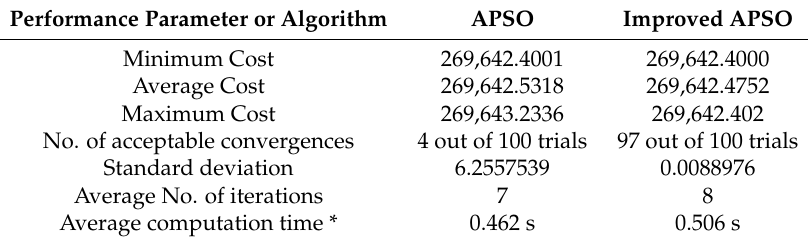
Table 2. Comparison of some performance parameters between APSO and improved APSO on the pumped storage STHTS problem.